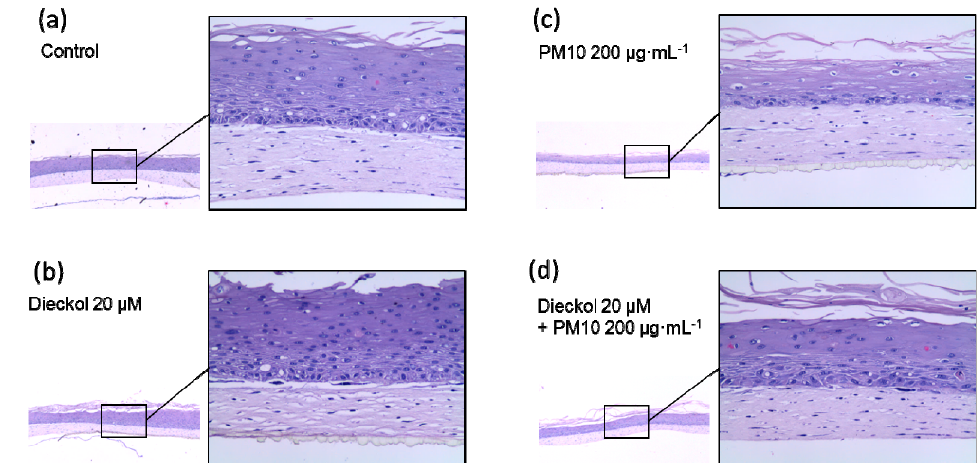
Figure 9. Protective effect of dieckol against PM10 in a skin model. 3D-reconstructed human skin models were treated for 48 h with vehicles ( a ), 200 µ g mL − 1 PM10 ( b ), 20 µ M dieckol ( c ), or 20 µ M dieckol plus 200 µ g mL − 1 PM10 ( d ). Representative images of the tissue sections stained with hematoxylin and eosin are shown. The magnifications for the small and the enlarged images of each tissue section are × 40 and × 200, respectively.